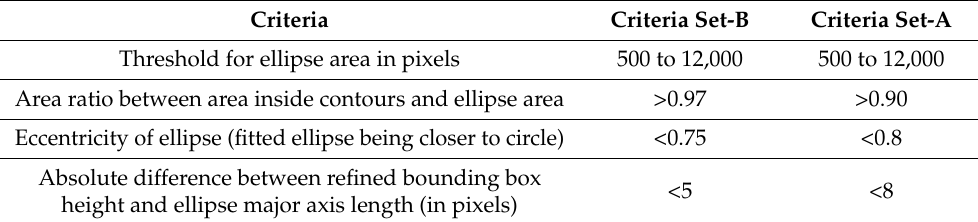
Figure 9. Examples of fruit occlusion by ( i ) leaf, ( ii ) other fruit; ( iii ) panicle. The criteria of Wang, et al. [9] on features of an ellipse fitted to the object were adopted (criteria set B) and adapted (criteria set A) to judge whether a mango fruit was occluded or completely imaged (Table 2). Table 2. Criteria sets for identification and exclusion of partly occluded fruit. Criteria